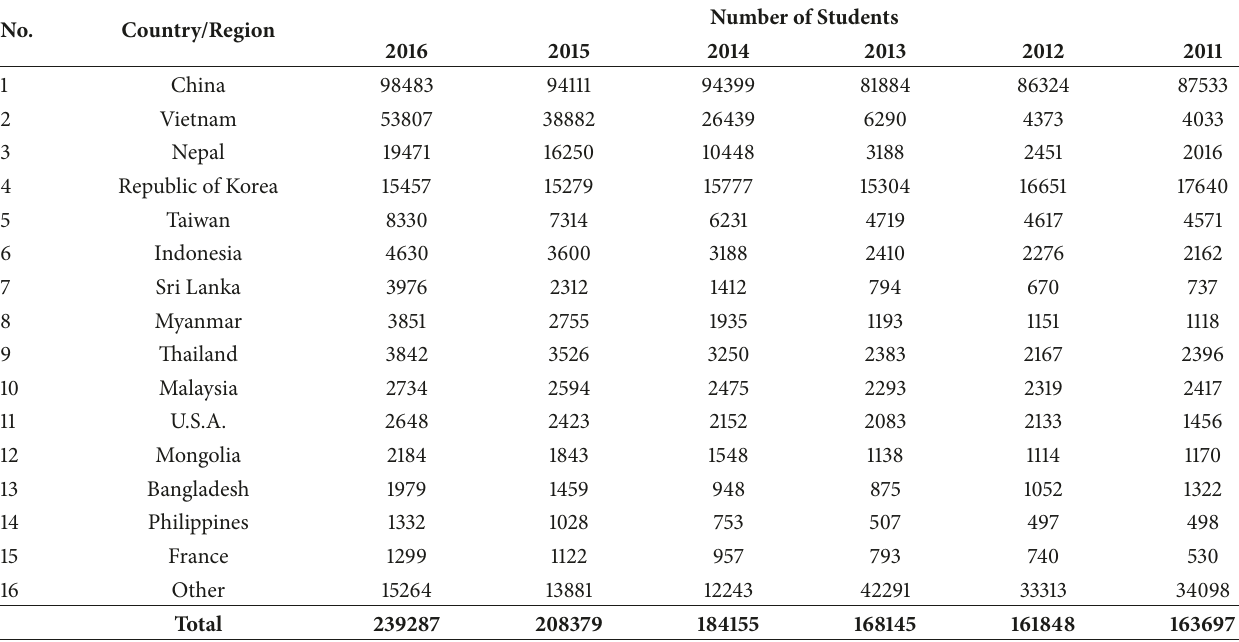
Table 1: Number of International Students Based on Nations.